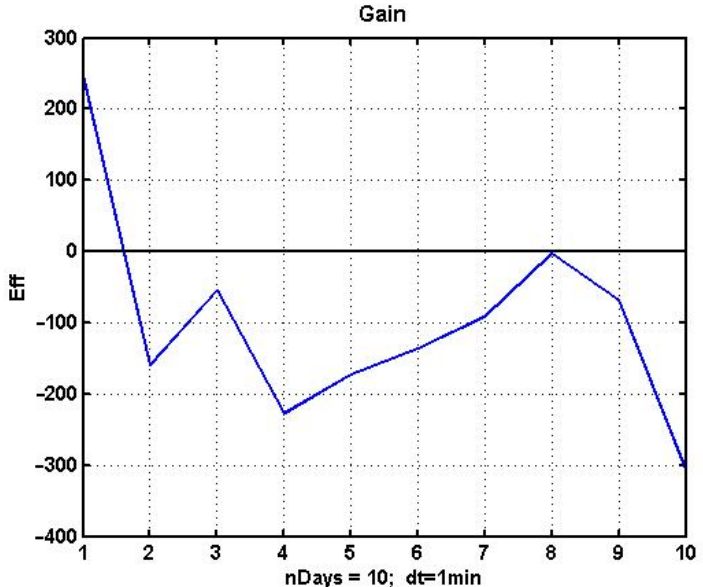
Figure 5. Performance of applying the CSF strategy with parameters optimal for the first day to the next nine days of management.